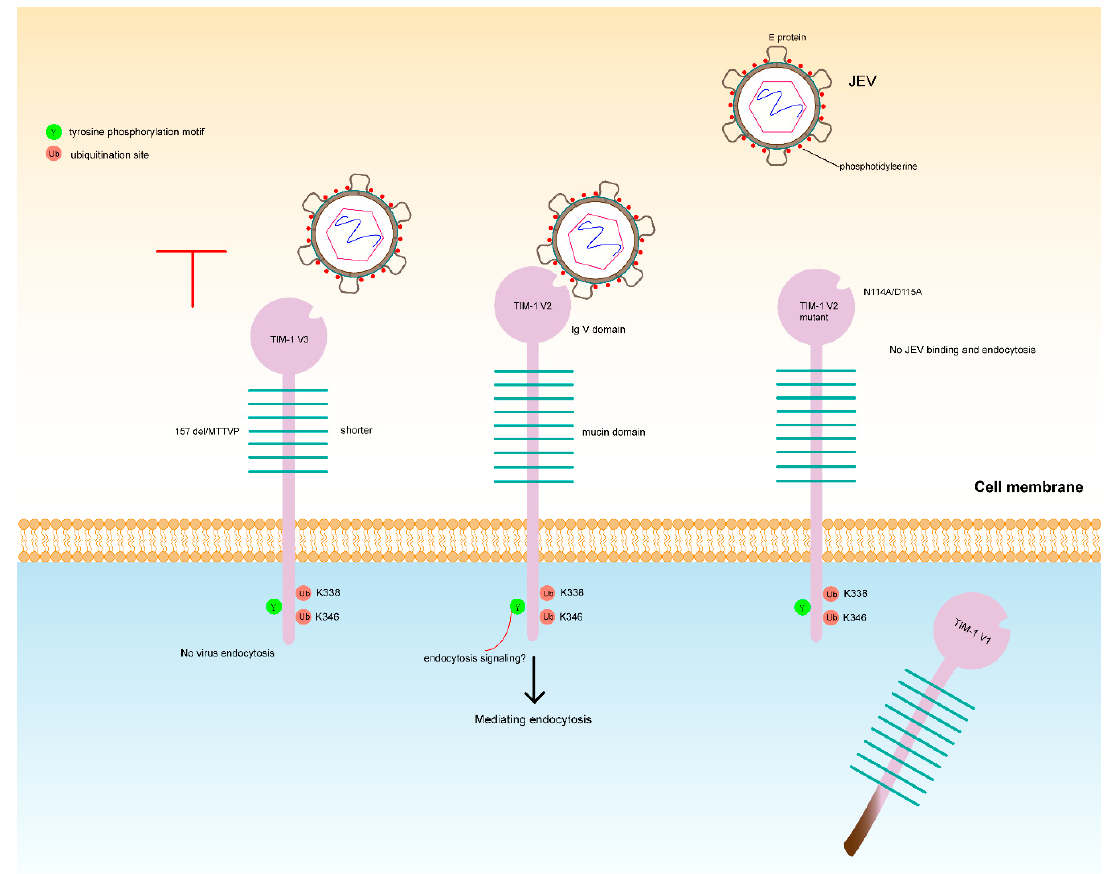
Figure 7. Hypothetical model of TIM-1 mediated JEV infection.